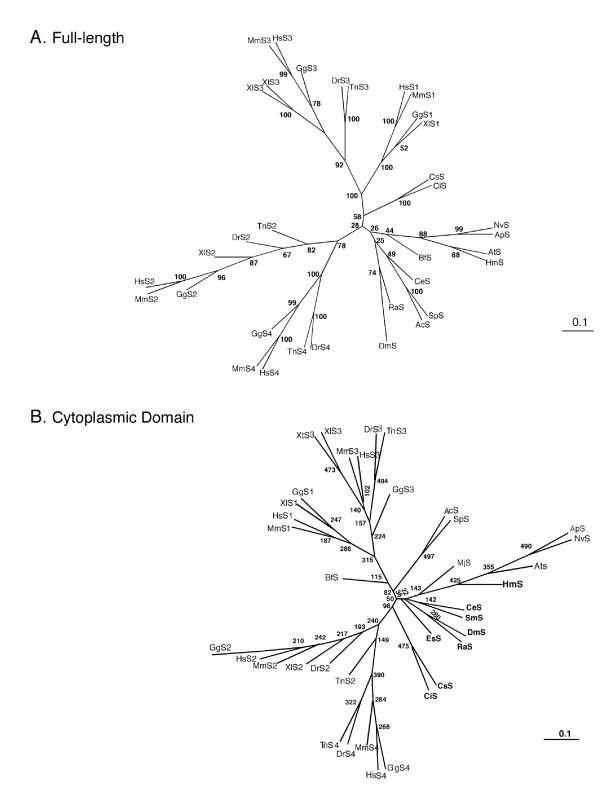
Phylogenetic trees of full-length and cytoplasmic domain of syndecans. The CLUSTALW outputs of TCOFFEE alignments of the amino acid sequences of (A), full-length, and (B), cytoplasmic domains, of syndecans in our dataset were used to generate unrooted phylogenetic trees by the maximum likelihood reconstruction method, PHYML, using the WAG substitution model. Bootstrap analysis was run for 100, (A), or 500, (B), cycles and the bootstrap replication values are shown at each node. Scale bars = 0.1 substitution/site.